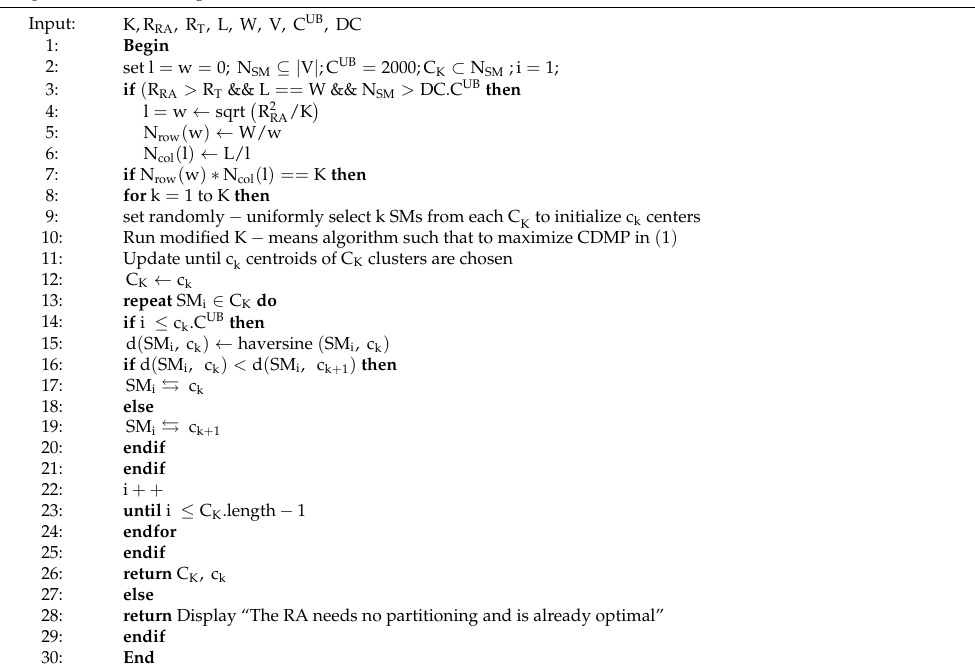
Algorithm 1 for dividing the residential area into virtual clusters.